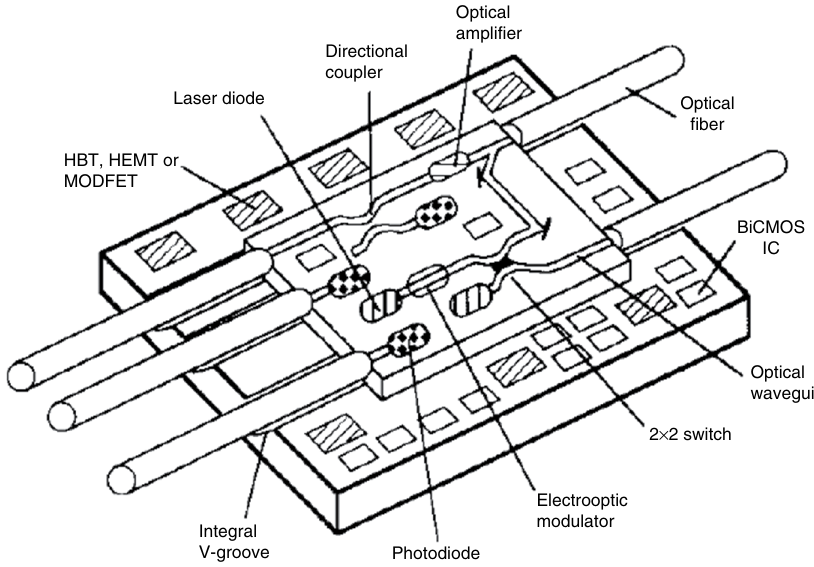
Figure 1 One of the original proposals for an optoelectronic integrated circuits on silicon [10], acknowledging the inevitable heterogeneous destiny of the technology.